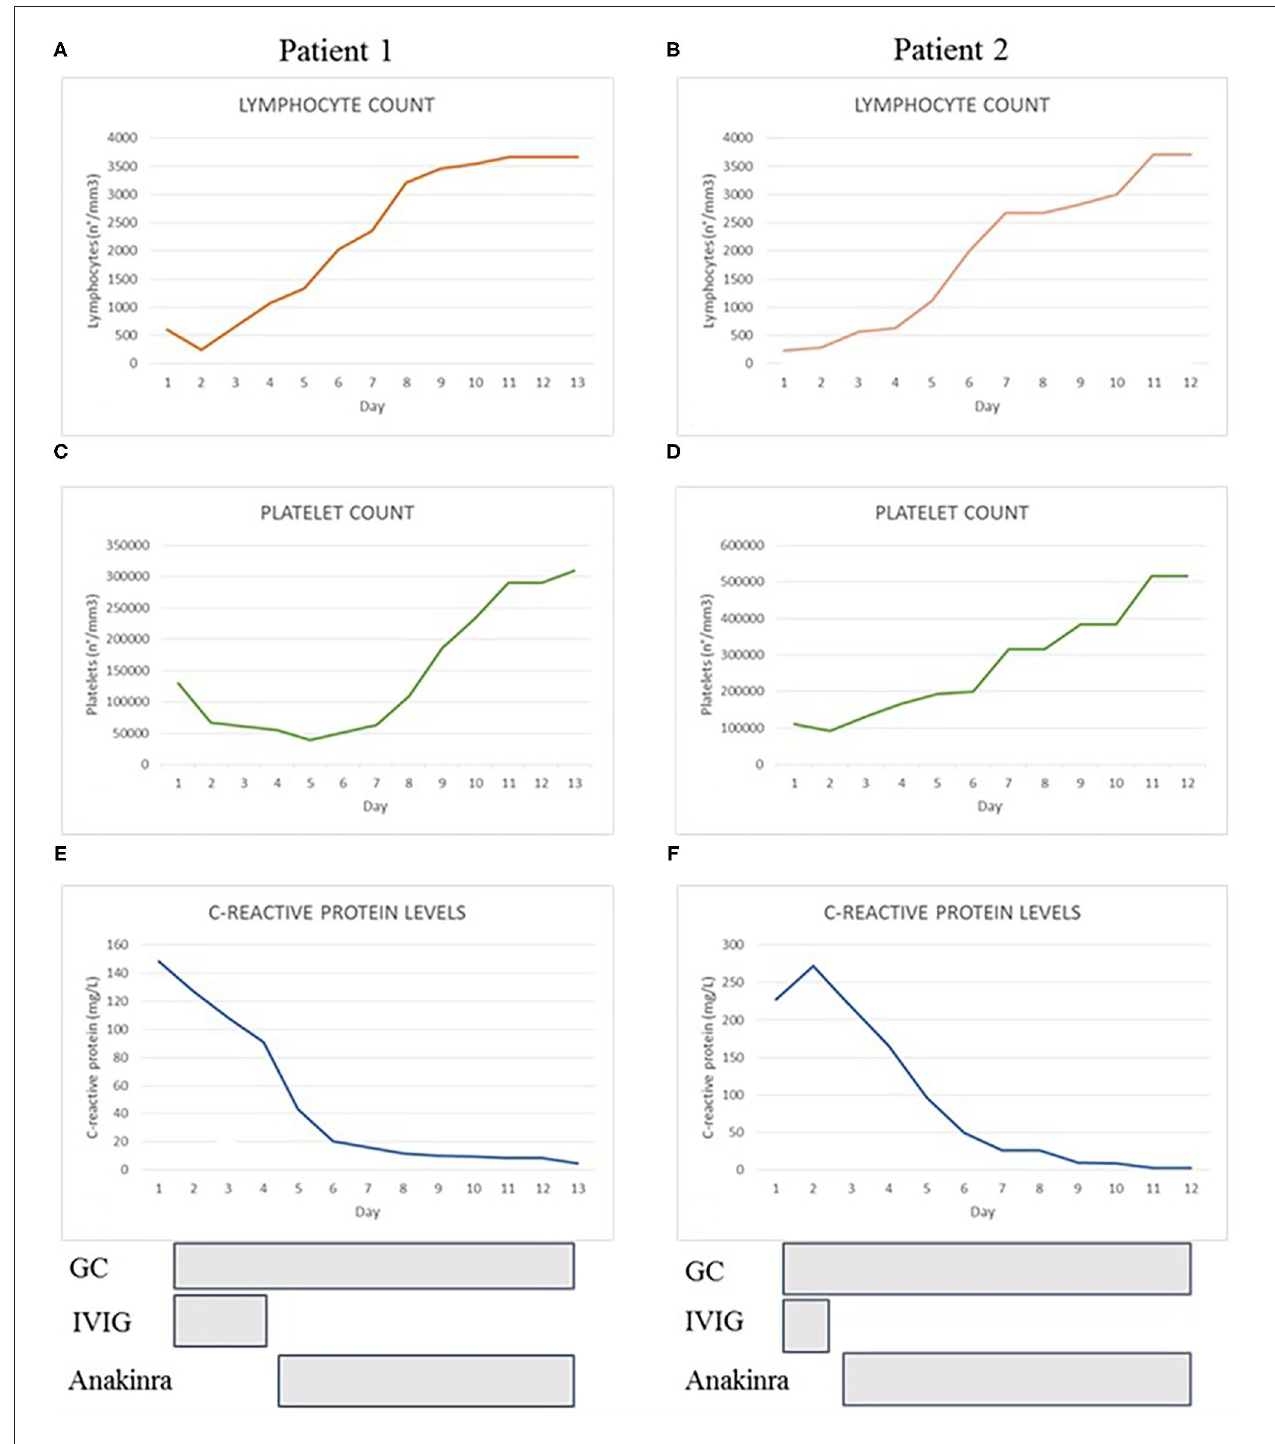
FIGURE 1 | The graphs show the trend of lymphocyte count (A,B) , platelet count (C,D) and C-reactive protein levels (E,F) of both patients during hospitalization. At the bottom we reported the duration and the timing of treatment with glucocorticoids (GC), immunoglobulins (IVIG), and anakinra. inflammatory-related coagulopathy, we can assume that further TNF alfa and IL-6; accordingly IL-1R blockade was reported decrease of fibrinogen levels after starting anakinra could be the to decrease fibrinogen levels (30). Thus, while in the first results of IL-1 blockade. This interpretation is supported by the phase of the disease hypofibrinogenemia was secondary to the